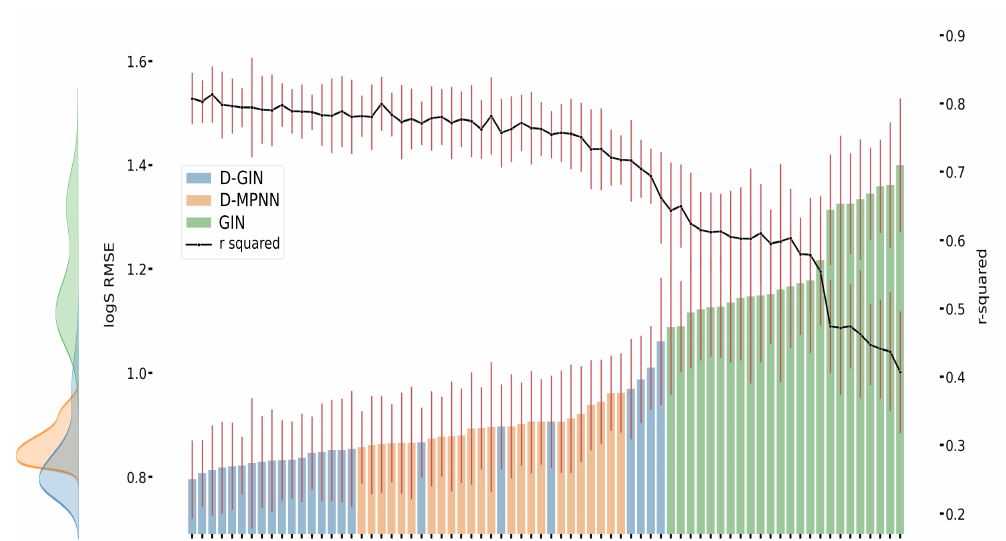
Figure 4. LogS prediction results for each GNN model instance. The left y-axis specifies the logS RMSE and the right, secondary x-axis the corresponding r 2 values for each GNN model. D-GIN is colored blue, D-MPNN orange, and GIN green. Each of the bars represent a different trained model-a detailed description can be found in Figure A3 in the Appendix A. The accumulated kernel density for each model type is shown on the very left side. The red lines correspond to the 95% confidence intervals. The model names are a combination of model type (D-GIN, GIN, D-MPNN), training approach and featurization type-a detailed description of each model name can be found in Tables A8–A19 in the Appendix A.